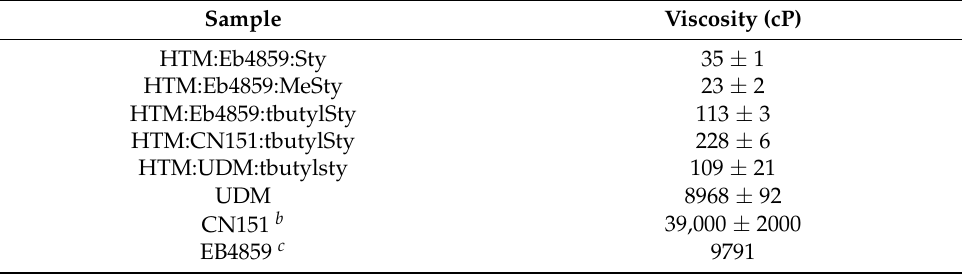
Table 4. Viscosity of HTM ternary formulations and neat crosslinkers a .